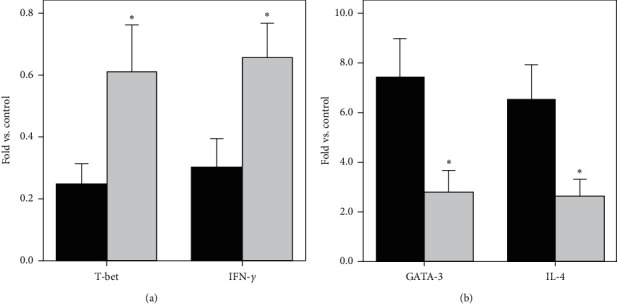
Effect of acupuncture and moxibustion on mRNA expression of transcription factors and cytokines in PBMC. (a) The mRNA expression of T-bet and IFN-γ increased obviously at week 4 (grey) compared with baseline (black). (b) The mRNA expression of GATA3 and IL-4 decreased remarkably at week 4 (grey) compared with that at baseline (black). ∗P < 0.01 (Student's t-test).